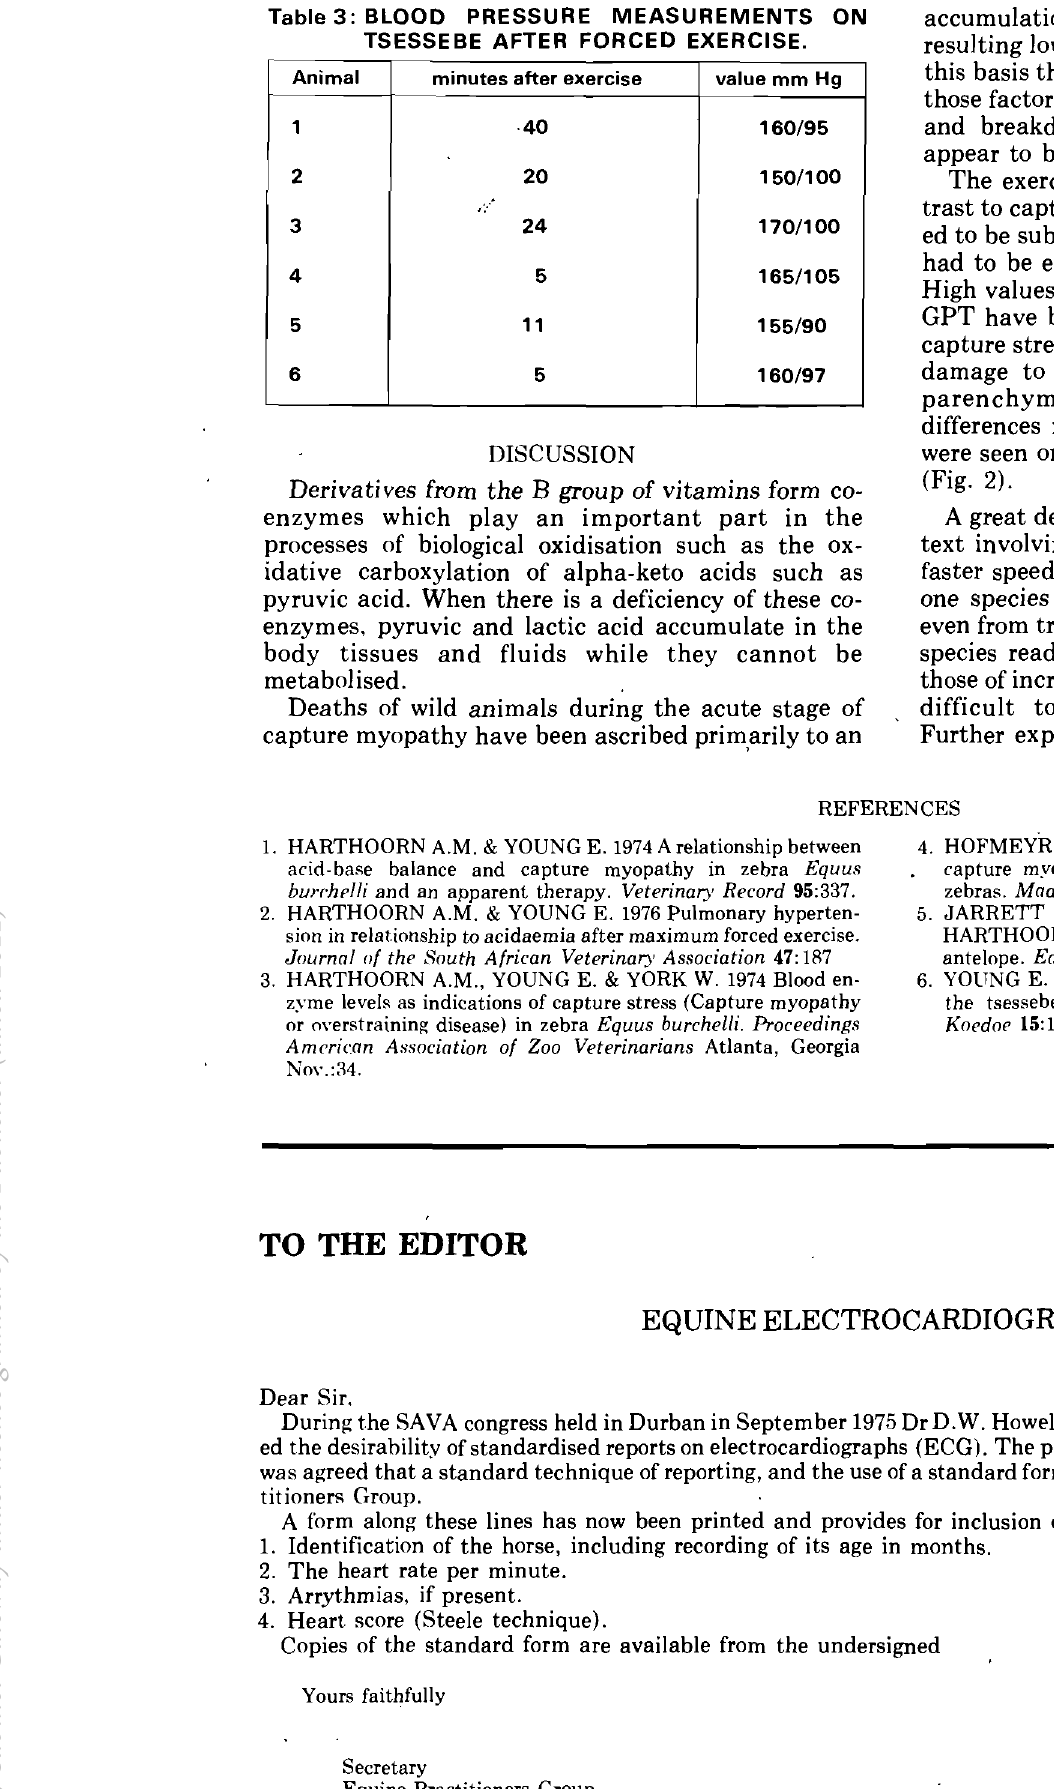
Table 3: BLOOD PRESSURE MEASUREMENTS ON TSESSEBE AFTER FORCED EXERCISE.